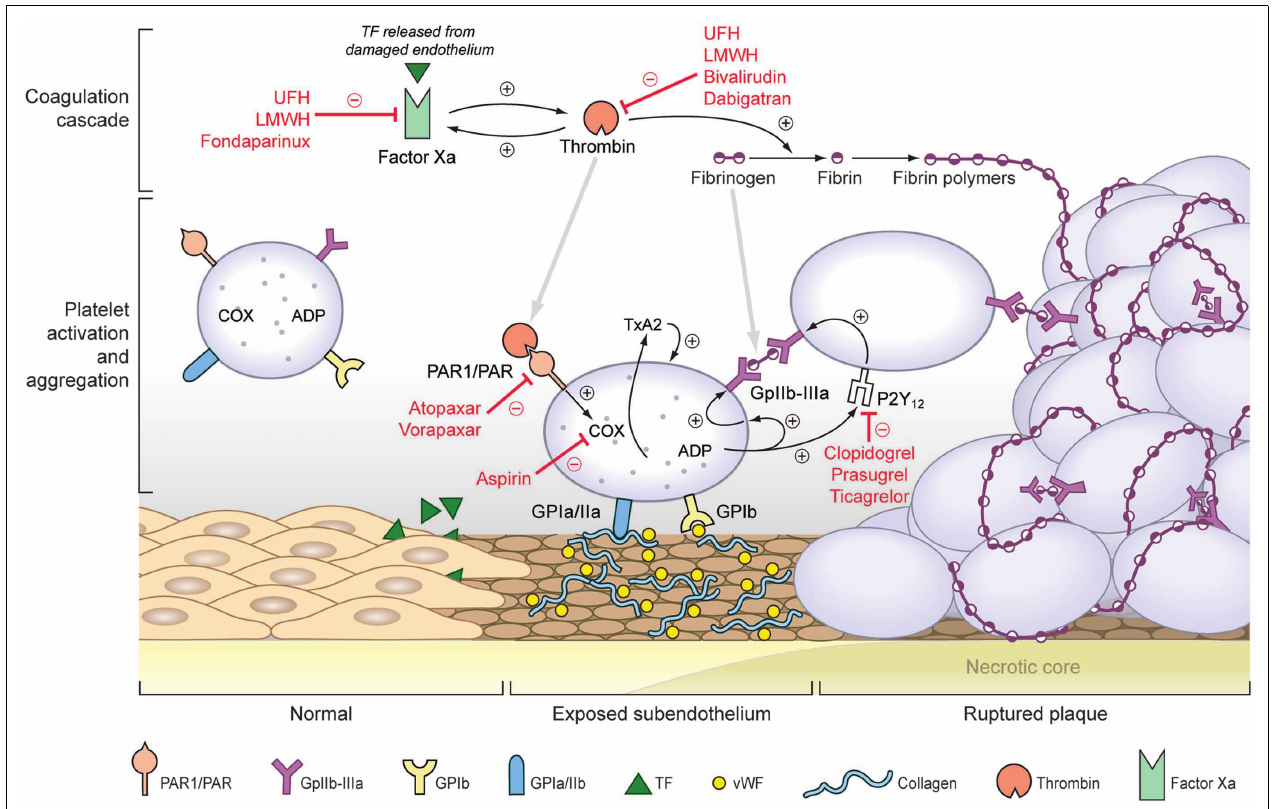
FIGURE 1 | Mechanism of acute coronary syndromes and targets of anti-platelet and anti-thrombotic